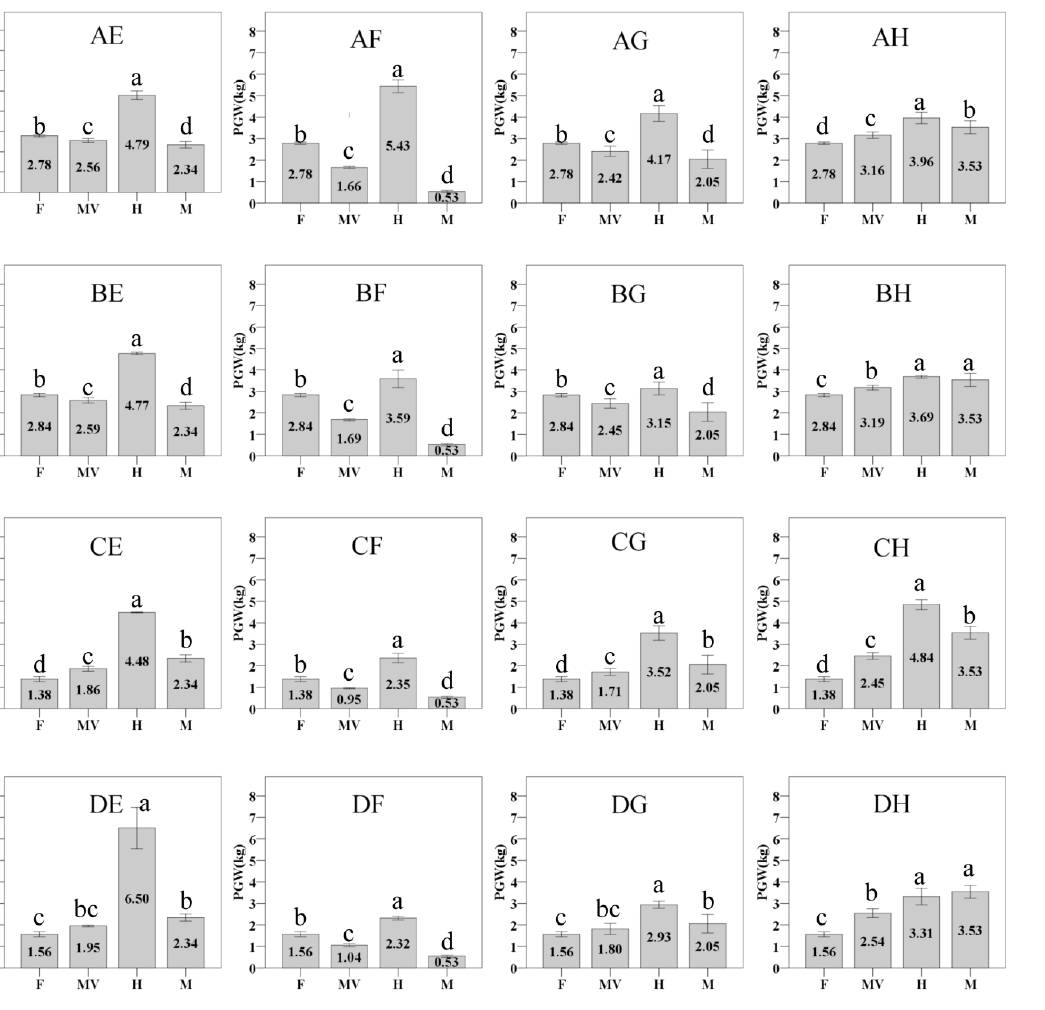
Figure 1. The plant’s gross weight of sixteen hybrids and eight parents. F: female parent; M: male parent; H: hybrid; MV:mid-parent value. The values are means ± SD. The different letters above each column are significantly different at p < 0.05 by Duncan’s test. Table 2. Mid-parent heterosis value analysis of plant gross weight in hybrids.